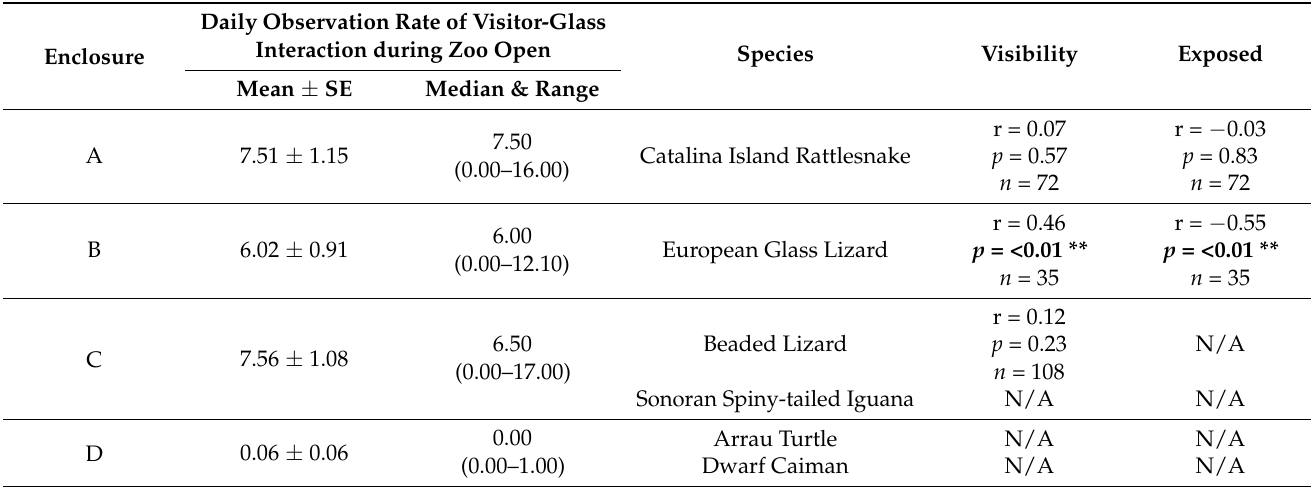
Table 6. Spearman correlation coefficients for the relationships between visitor-glass interactions and visibility and time exposed when visible. Significant differences of p ≤ 0.01 are bolded with a double asterisk (**). Values marked N/A indicate there was not sufficient variation in the measure to test a given